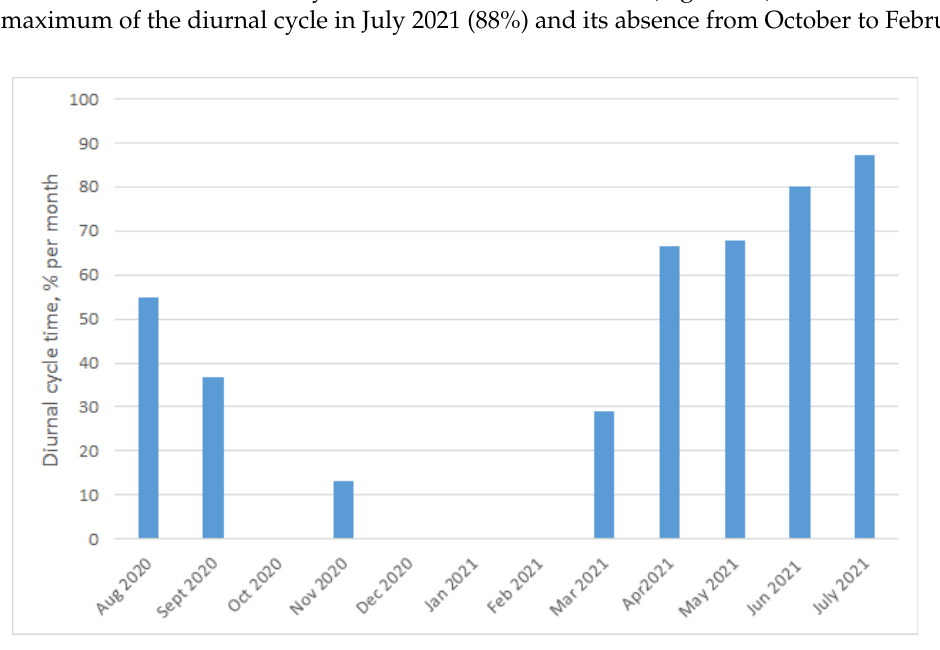
Figure 12. Repeatability of days with observed diurnal cycle for different months.